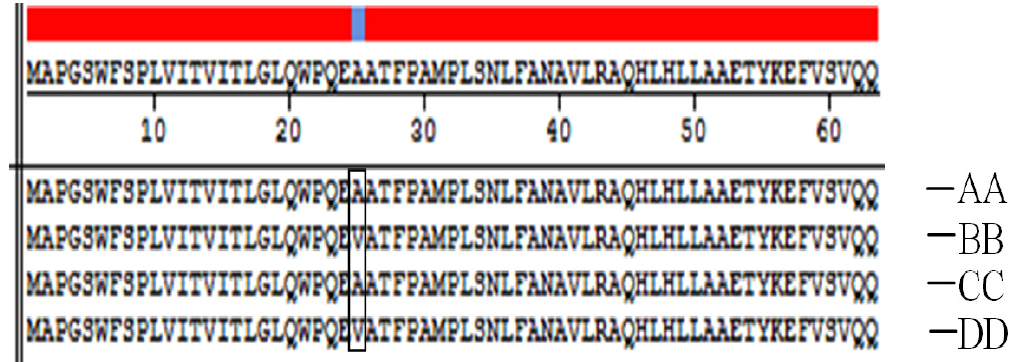
Figure 3. Amino acid sequence comparison of four genotypes. The 25th amino acid residue of the AA and CC genotypes is alanine ( A ), while that of the BB and DD genotypes is valine ( V